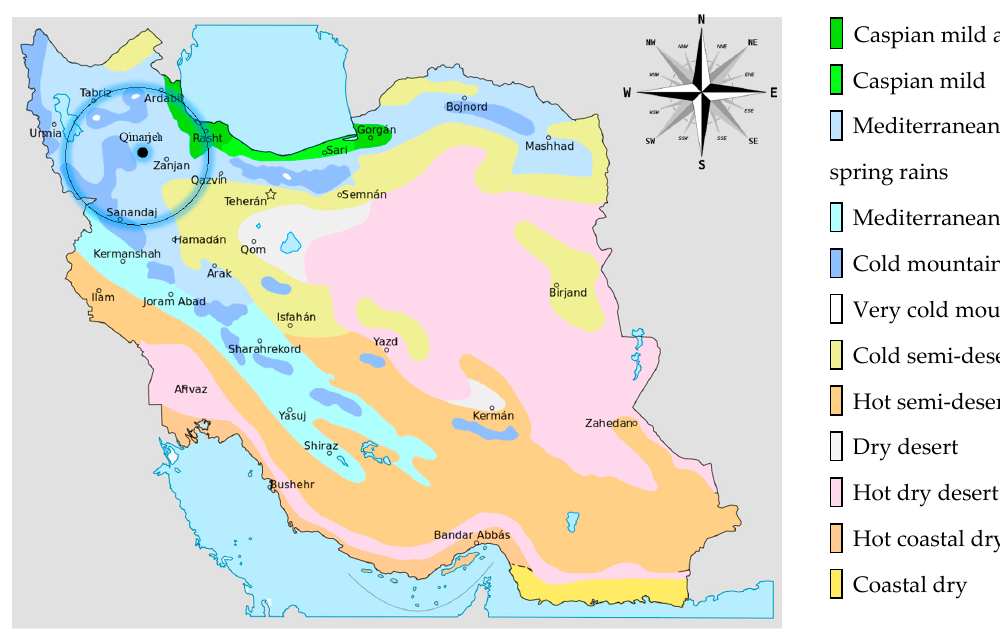
Figure 1. Classification of Iran climate map.